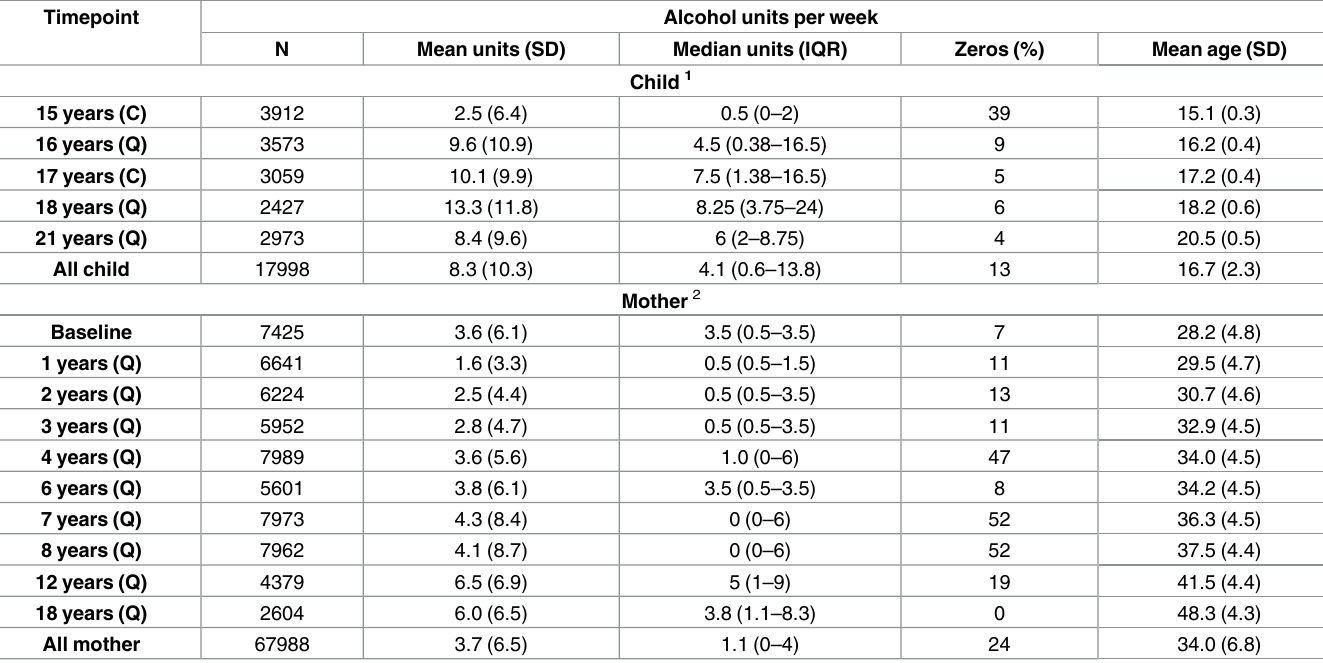
Table 1. Summaryinformation of weekly alcohol consumption across all time points.